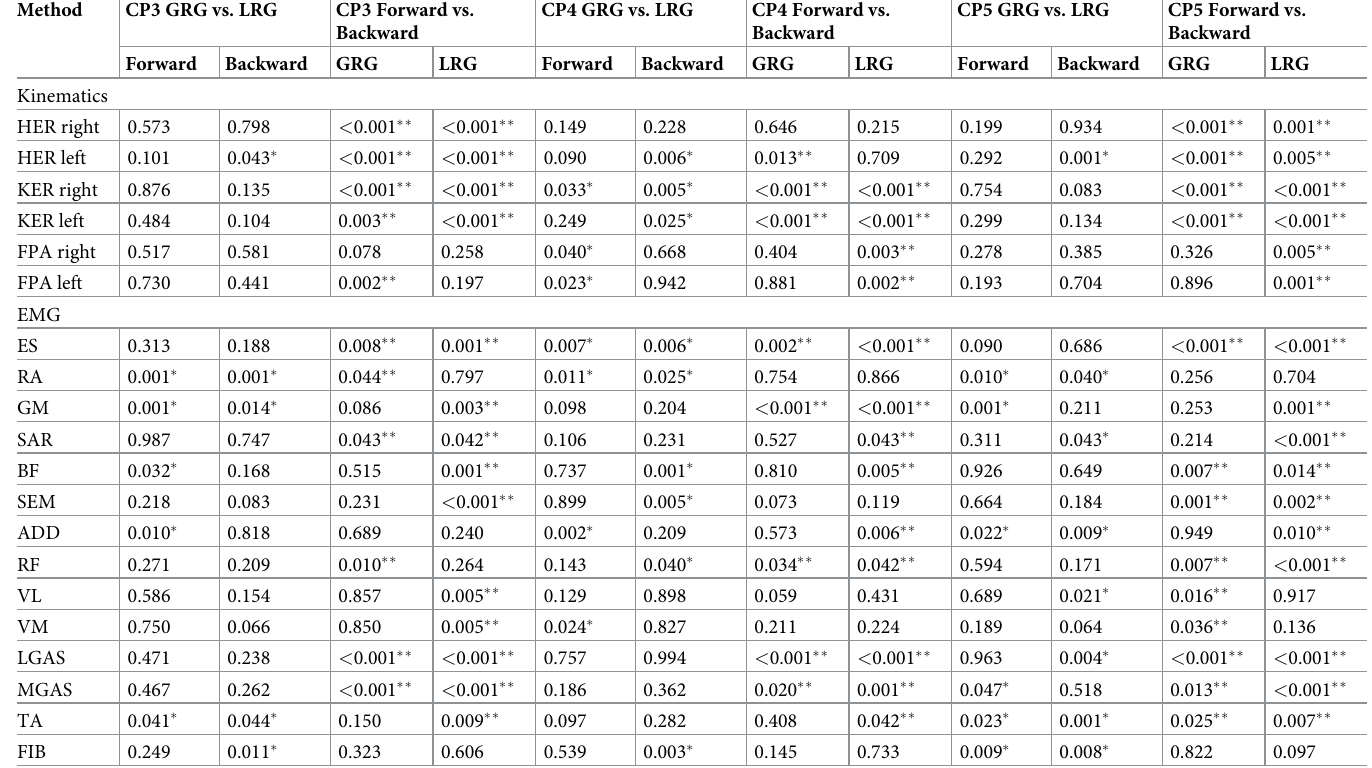
Table 6. P -values for comparisons between the groups and between the settings in the third classical position (CP3), the fourth classical position (CP4) and fifth classical position